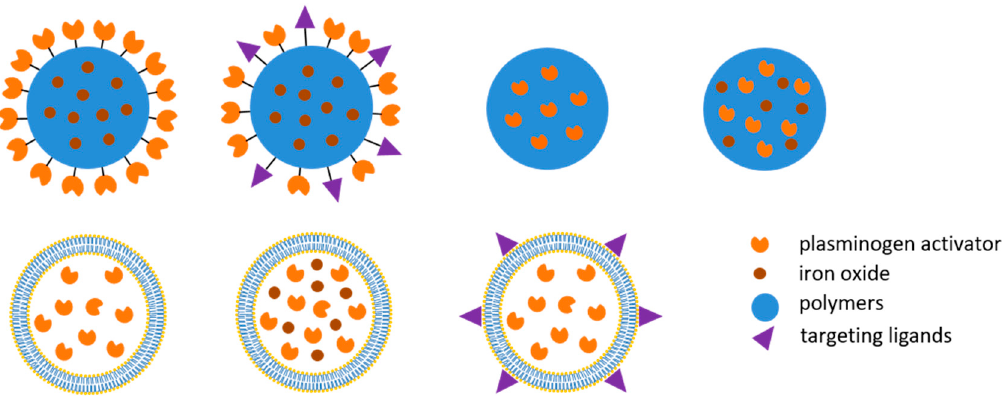
Figure 2. Illustration of thrombolytic nanocomposites demonstrating pharmacological efficacy in a disease model in vivo . Both immobilized and protected plasminogen activator in the polymeric (upper panel) and liposomal (lower panel) nanocomposites can be used.